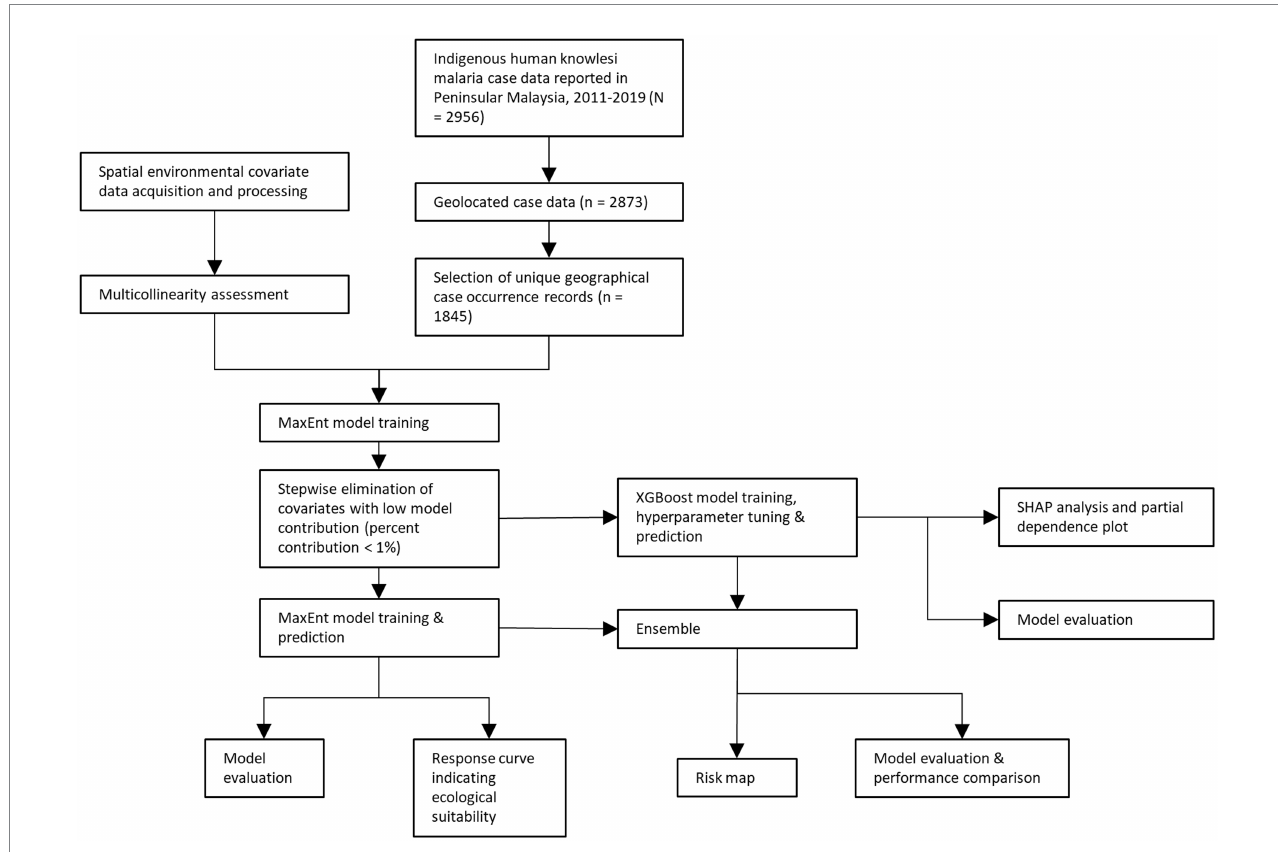
FIGURE 2 Schematic summarizing the modeling procedure in this